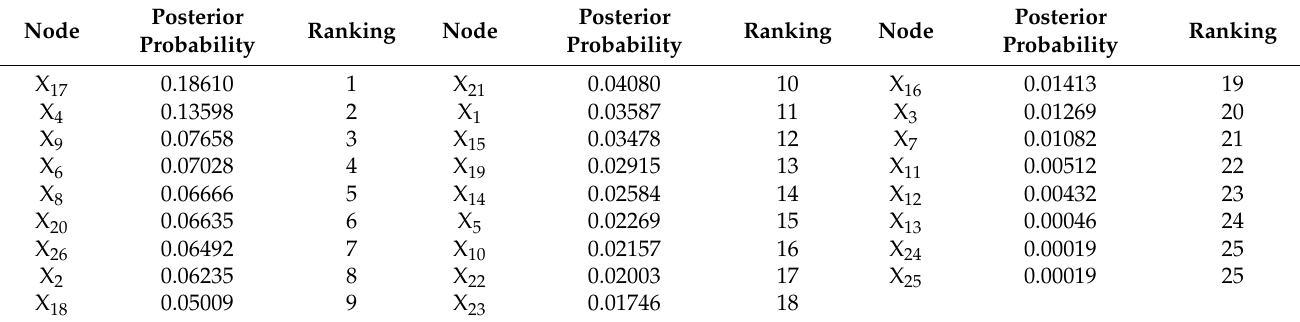
The comparison results of the prior probability and posterior probability of the root node are presented in Figure 7.